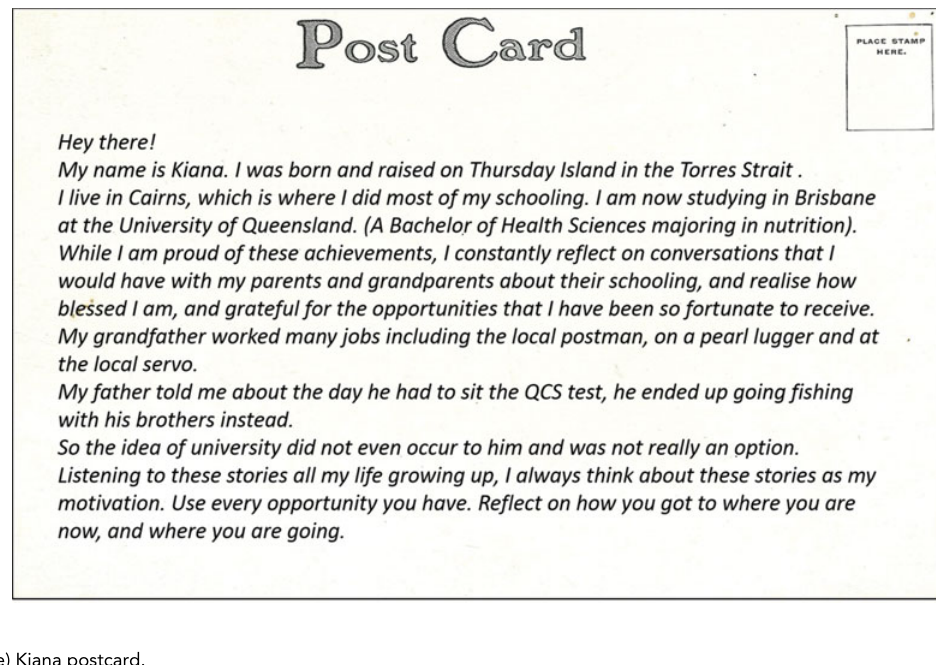
(Colour online) Kiana postcard.